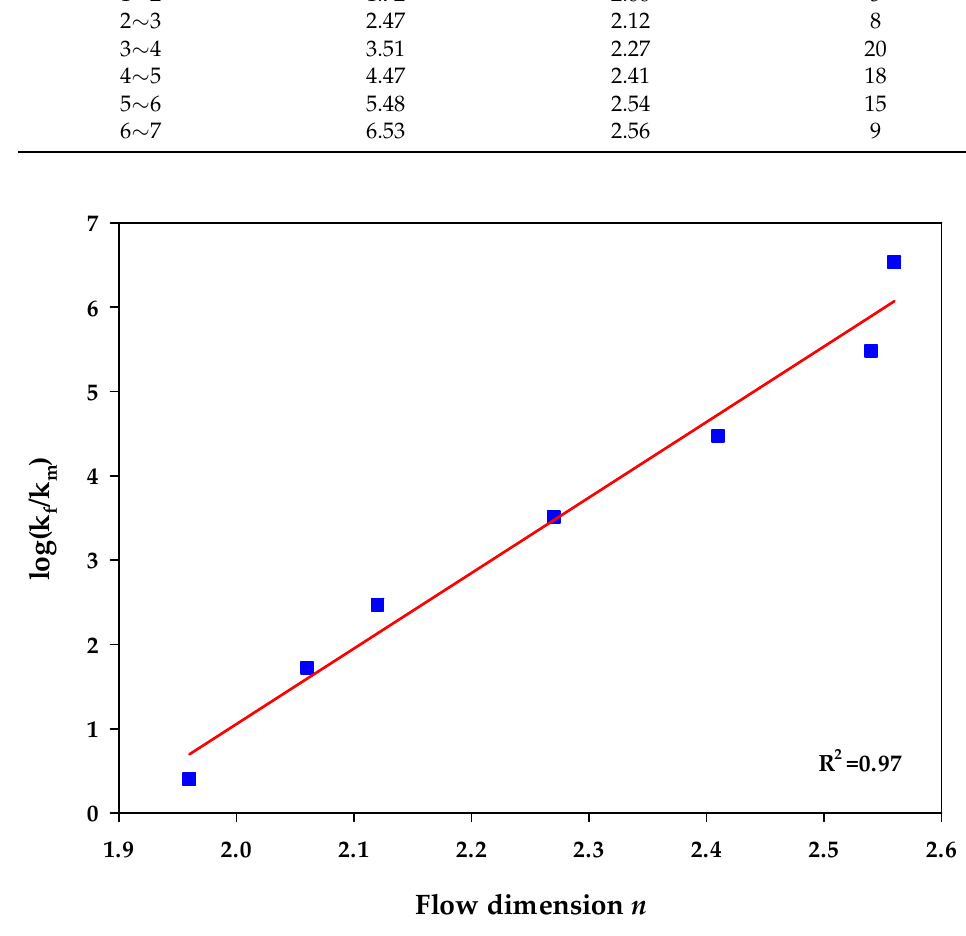
Figure 9. Relationship between n and K f /K m .